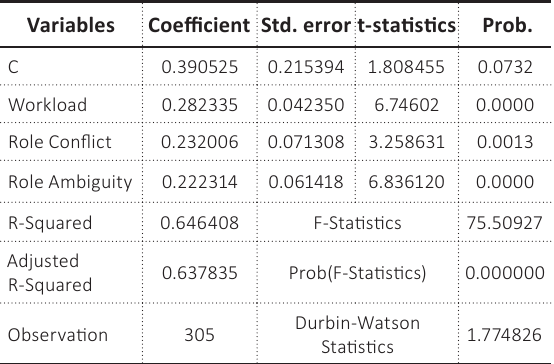
Table 13. When I have role conflicts, my administrative head gives me the kind of support